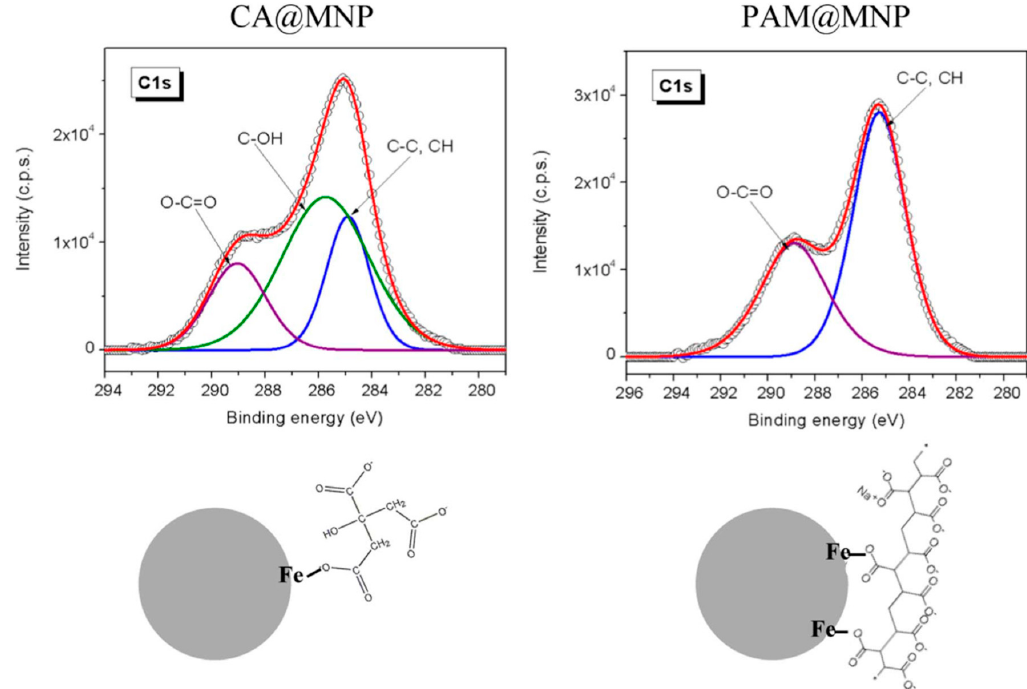
Figure 7. C1s spectra of the core-shell MNPs and the schemes of Fe–O–C(O)–R binding between MNP iron sites and organic carboxylates. Peak positions for CA and PAM coated MNPs: C-C, CH